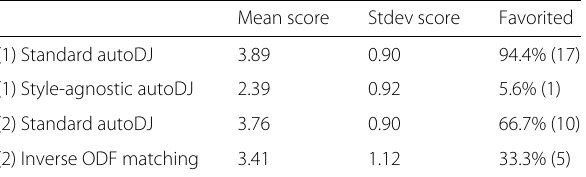
Table 5 User test results